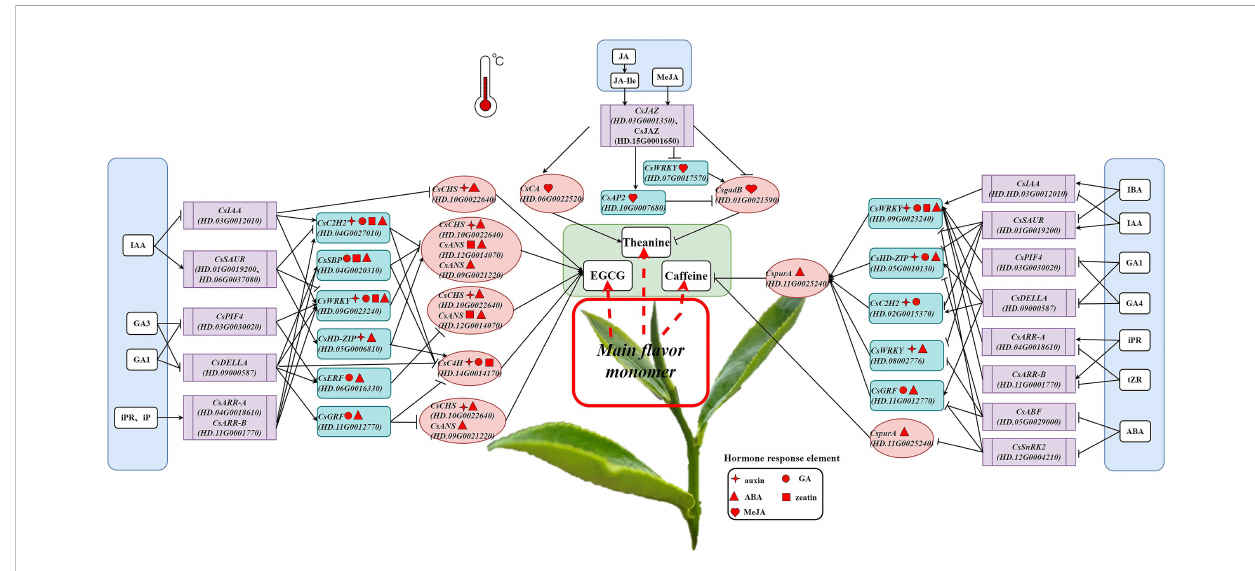
FIGURE 7 Mechanisms of the biosynthesis of EGCG, theanine and caffeine in response to temperature mediated by hormone signal transduction